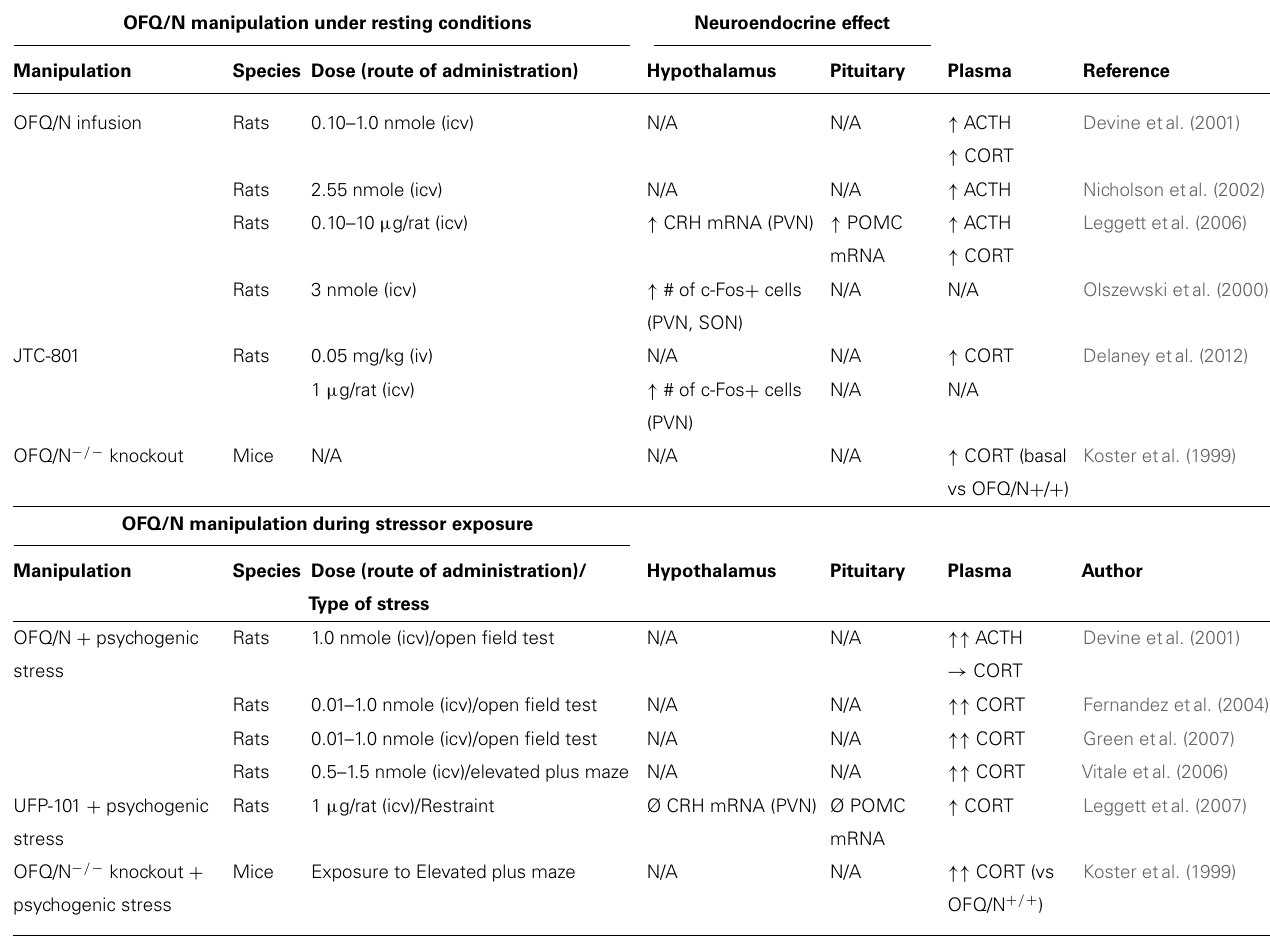
Table 1 | Effects of manipulating the nociceptin system on the hypothalamic-pituitary-adrenal (HPA) axis response in stressed and non-stressed animals. OFQ/N manipulation under resting